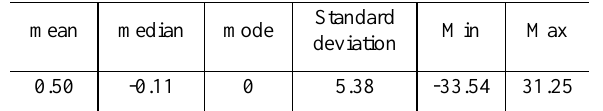
Figure 5. Histogram of overlap zone difference between track 40 and track 142